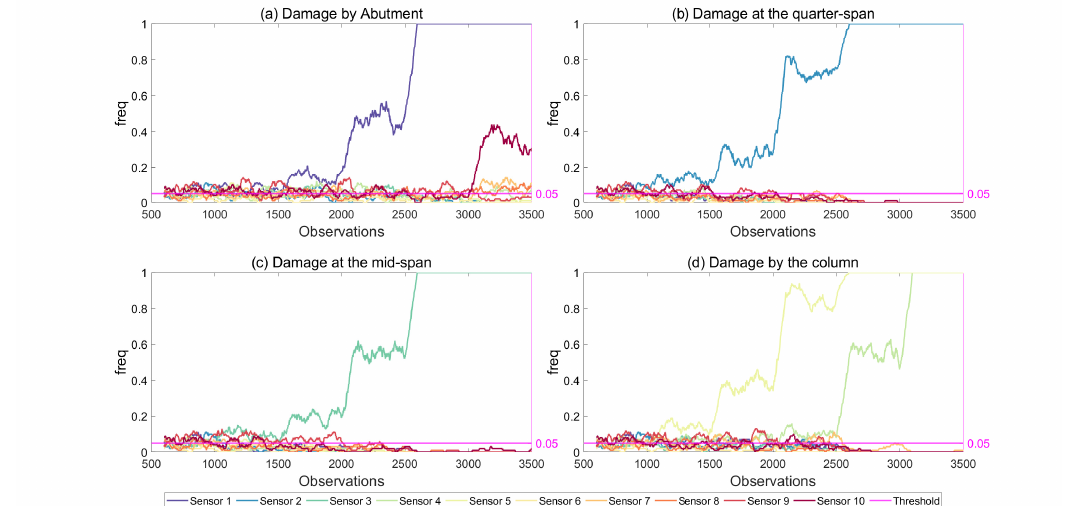
Figure 16. Frequency of exceedance using modal strain energy with two modes for all damage locations, 5% noise and 5%